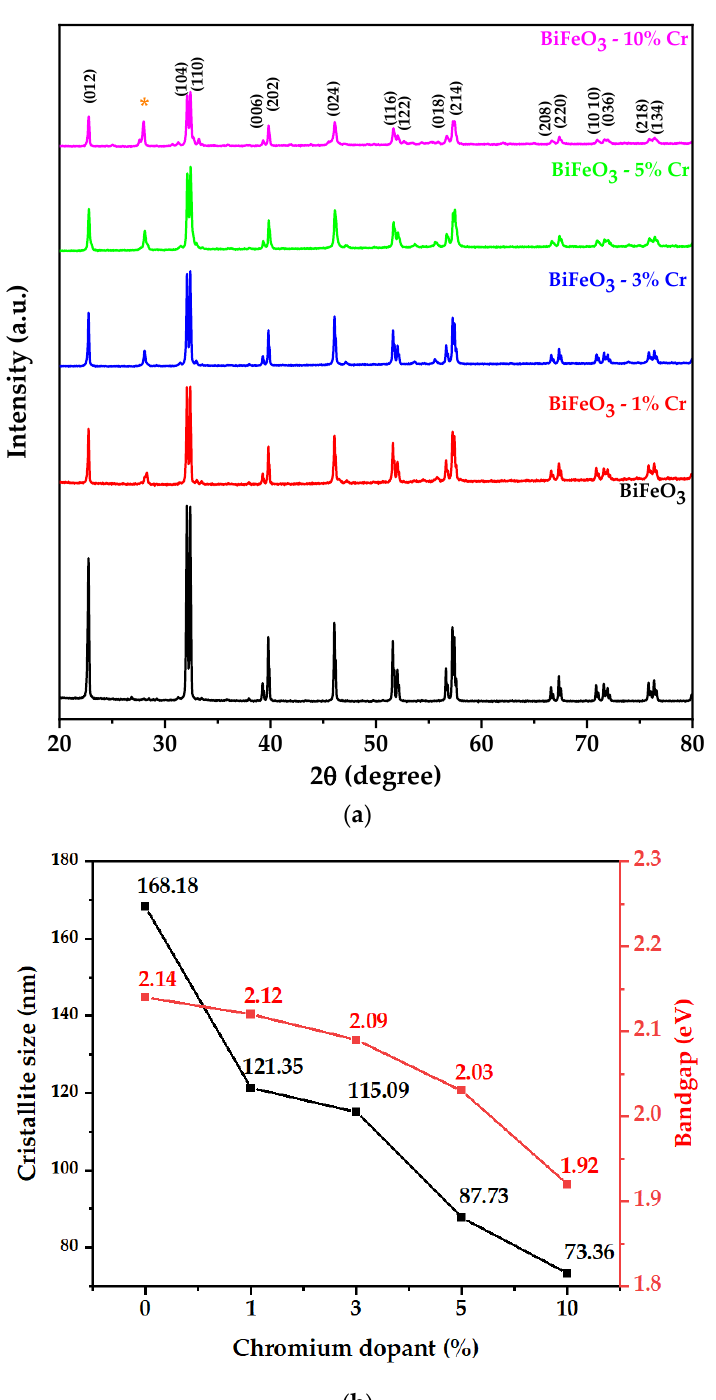
Figure 2. ( a ) X-ray diffraction pattern of pure and doped BiFeO 3 powder, and ( b ) influence of dopant on crystallite size and band gap. Table 2. Structural parameters of pure and Cr-doped BiFeO 3.